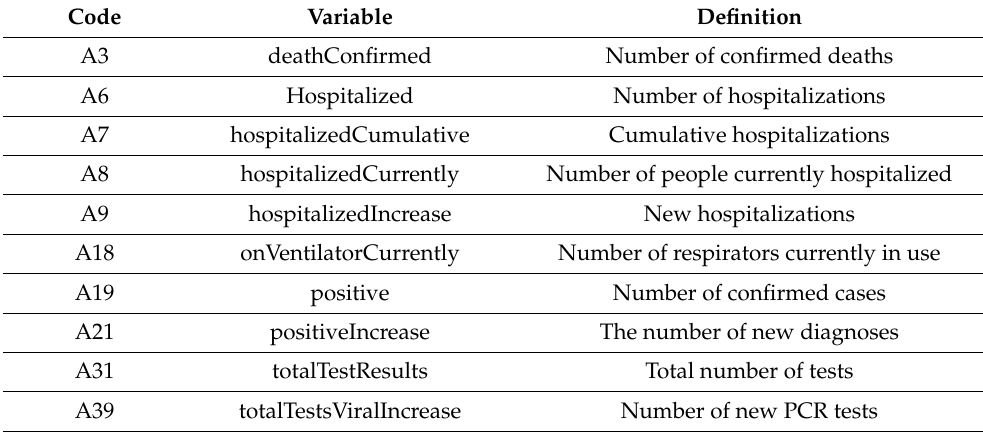
Table 6. Clustering